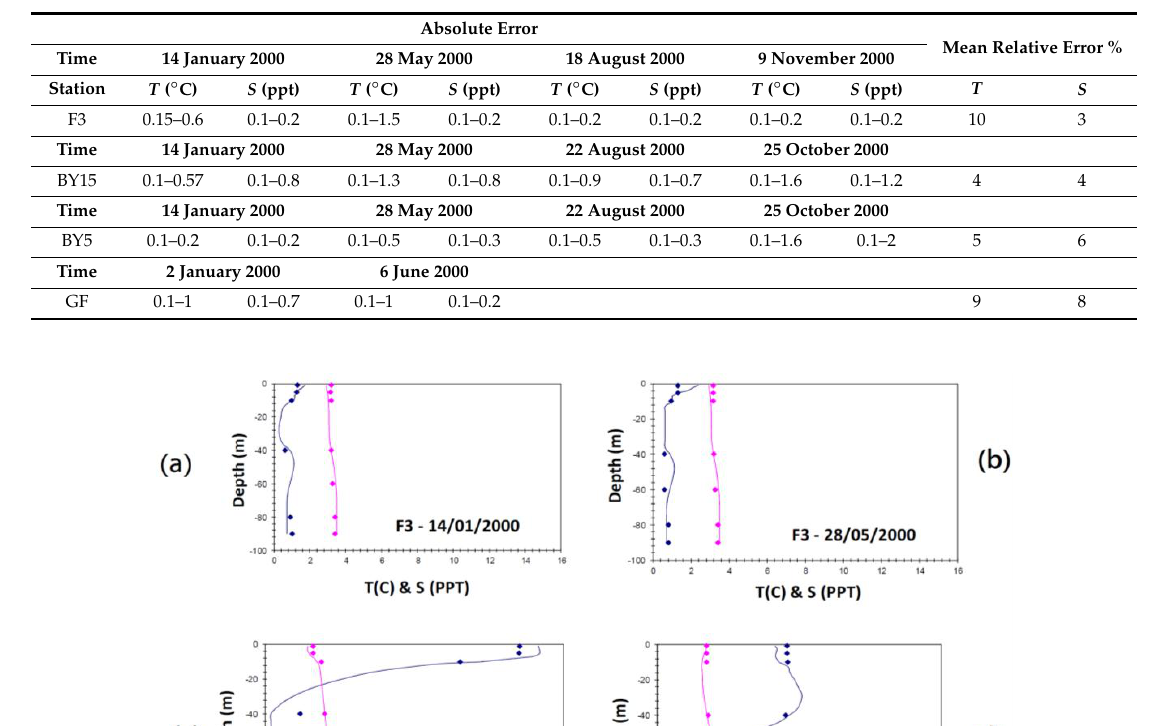
Table 1. Calibration error summary for temperature and salinity.